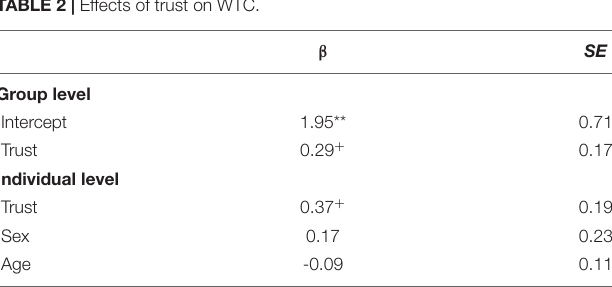
TABLE 2 | Effects of trust on